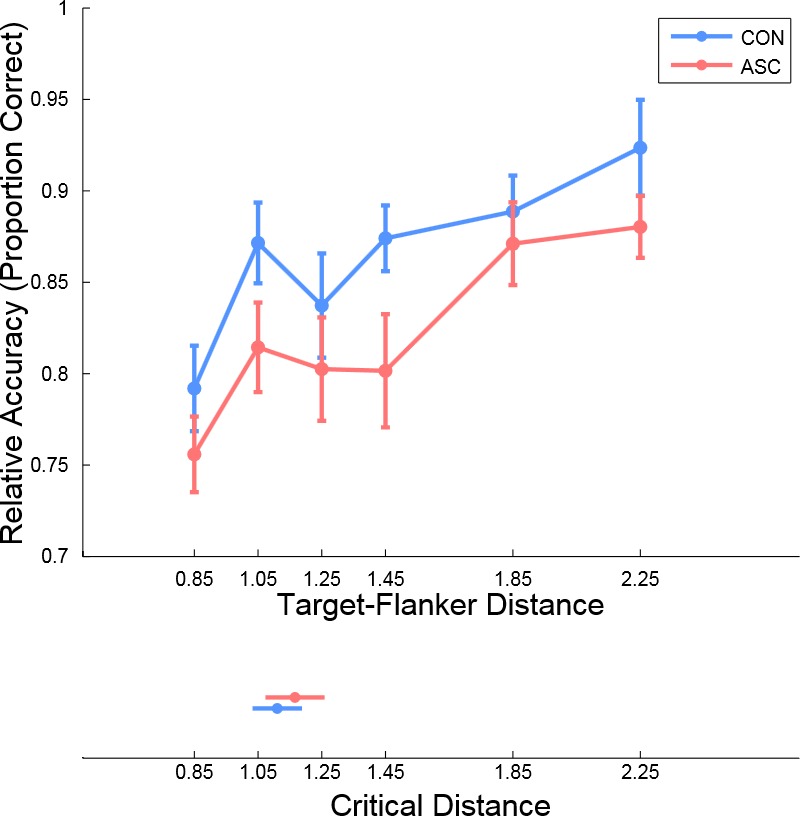
Results from Experiment 3. Mean accuracy of the two groups at the six target–flanker distances and the estimated critical distance for each group (inset). Error bars represent one standard error of the mean. Performance increased significantly with increasing target–flanker distance in both groups. The rate of this change was comparable between the two groups, and there was no overall difference in performance.